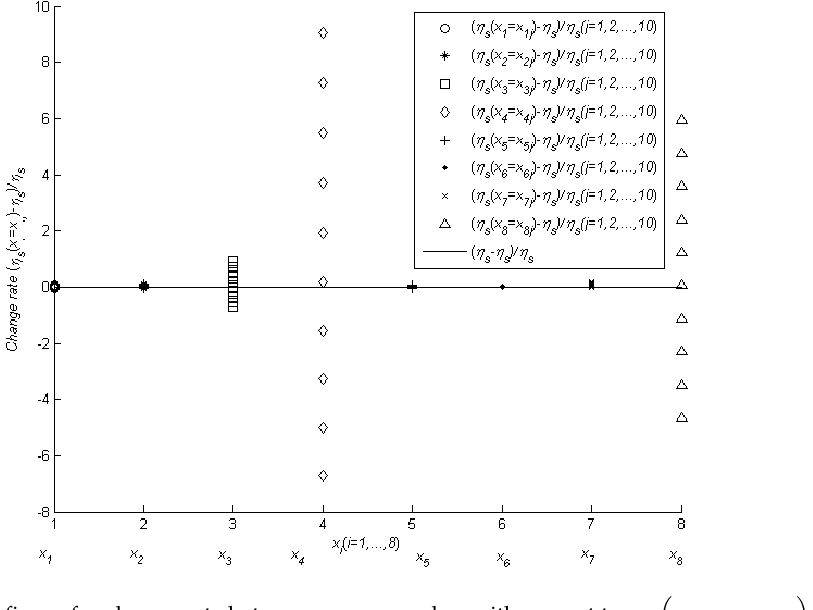
Figure 6. Point figure for change rate between η s | x with x i = x ij ( i = 1,2, . . . ,8; j = 1,2, . . . ,10 )